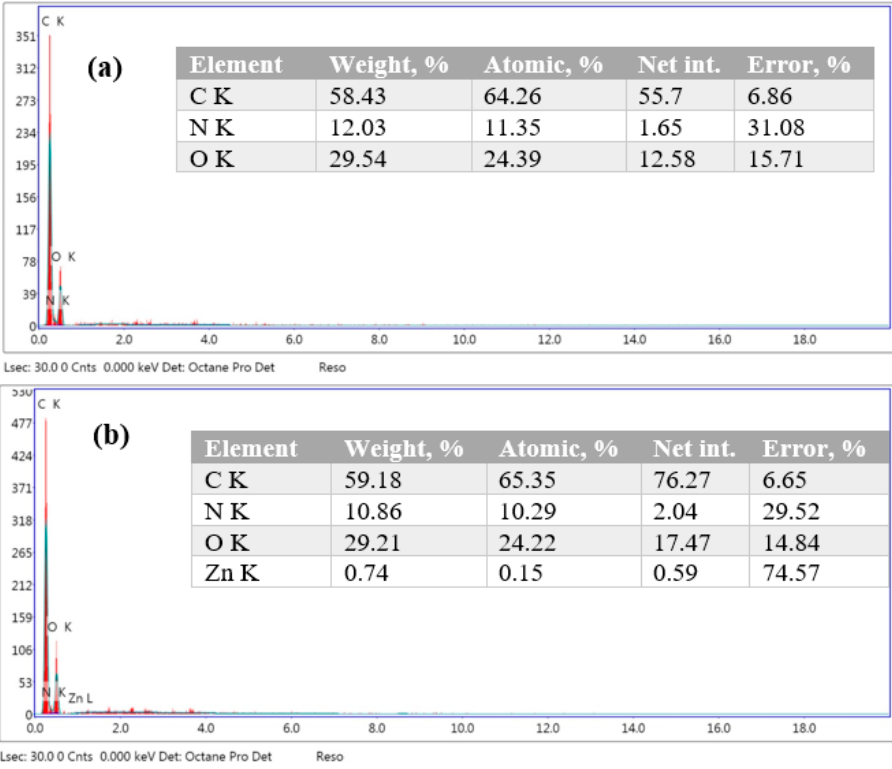
Figure 5. EDX spectra of a ) neat PUF and b ) PUF/rGO/ZnO nanocomposite.